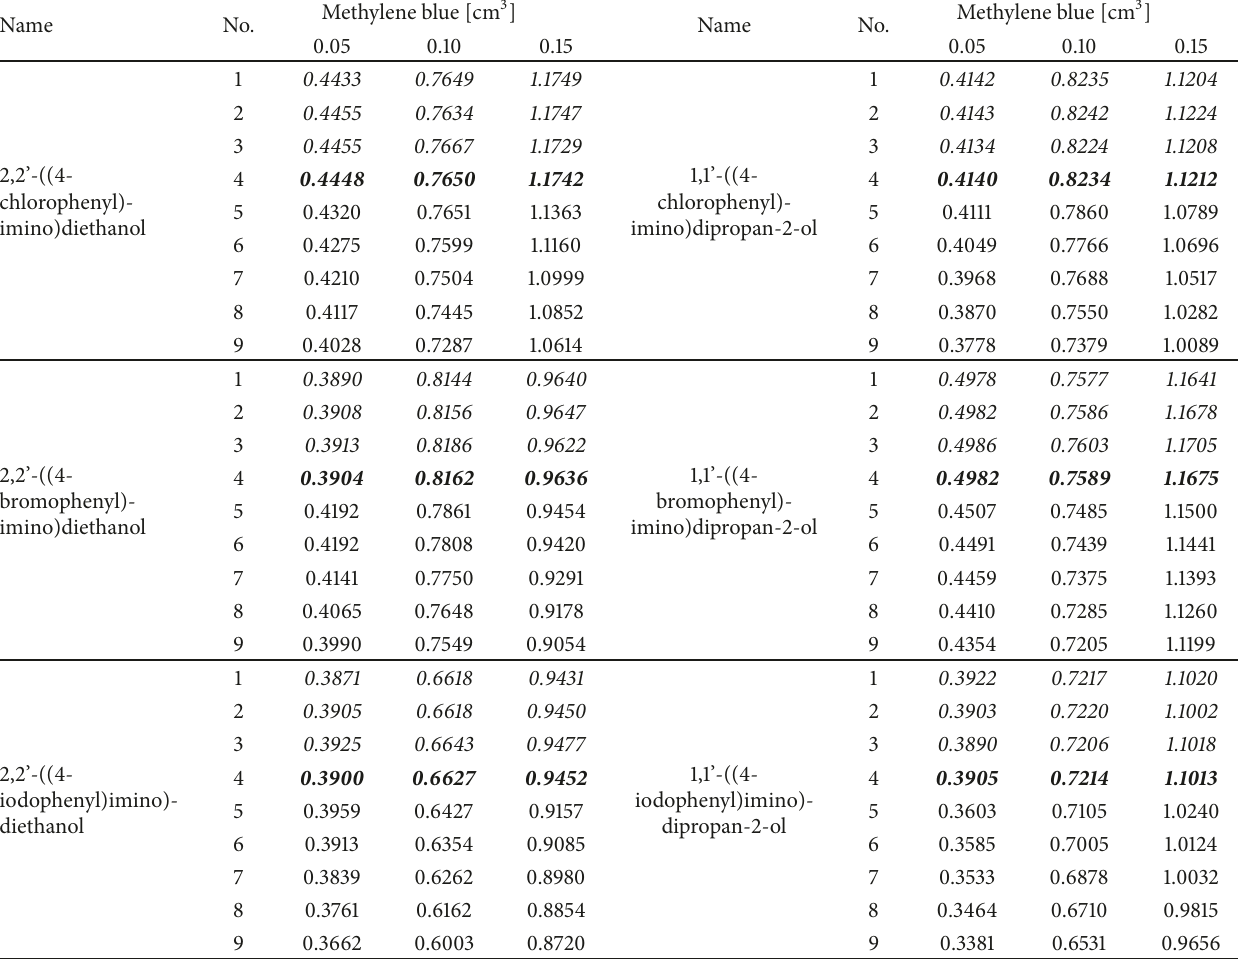
Table 2: Measured data (absorbance values) for blind (1-3 [italic]), average of blind (4 [bold italic]), and proper (5-9) samples in function of